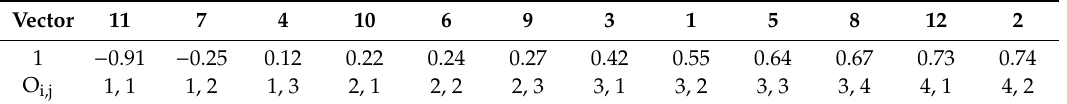
Table 10. Results of the sequencing machine operation.